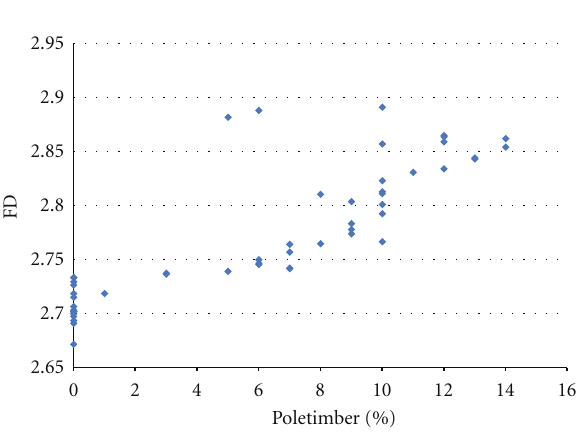
Figure 7: FD versus sawtimber.